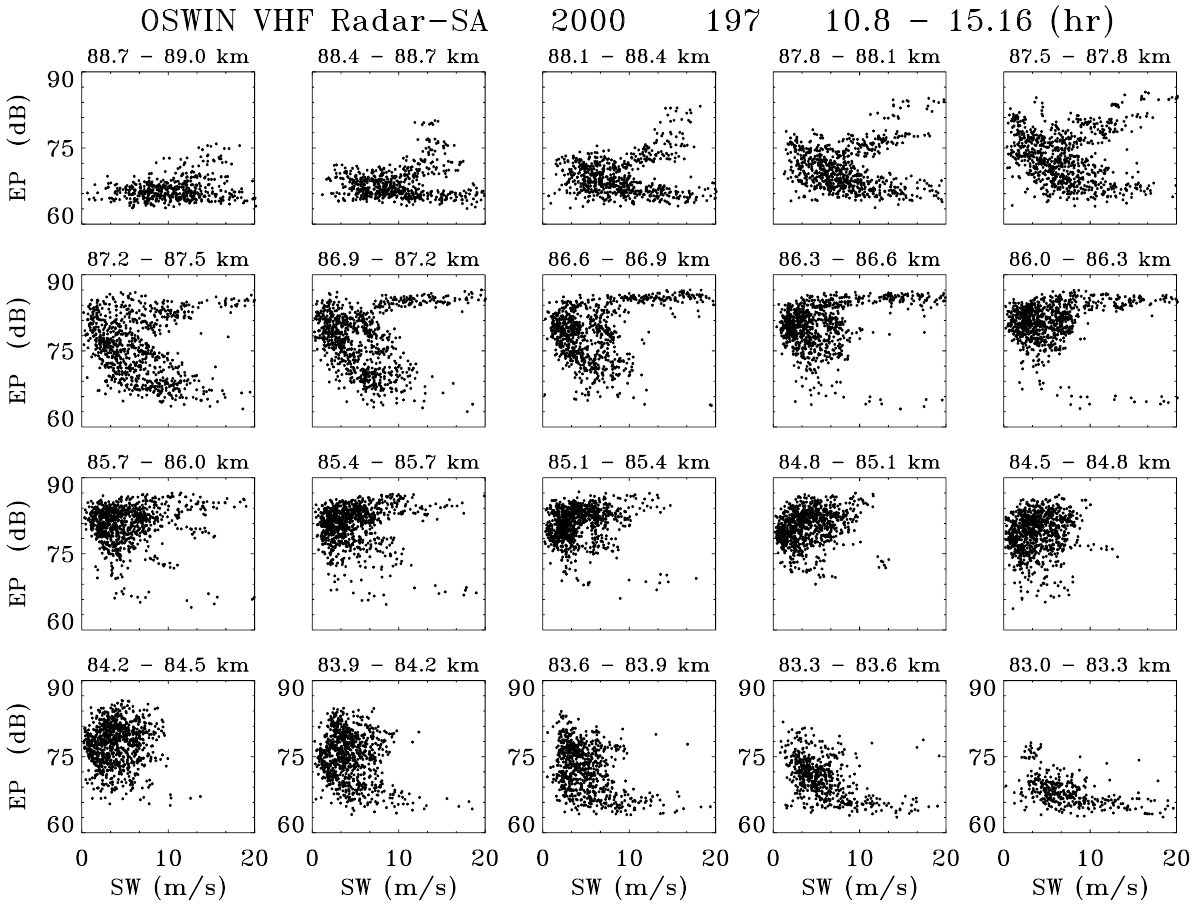
Fig. 6. Scatter plots of echo power (EP) versus spectrum width (SW) for the data set shown in Fig.